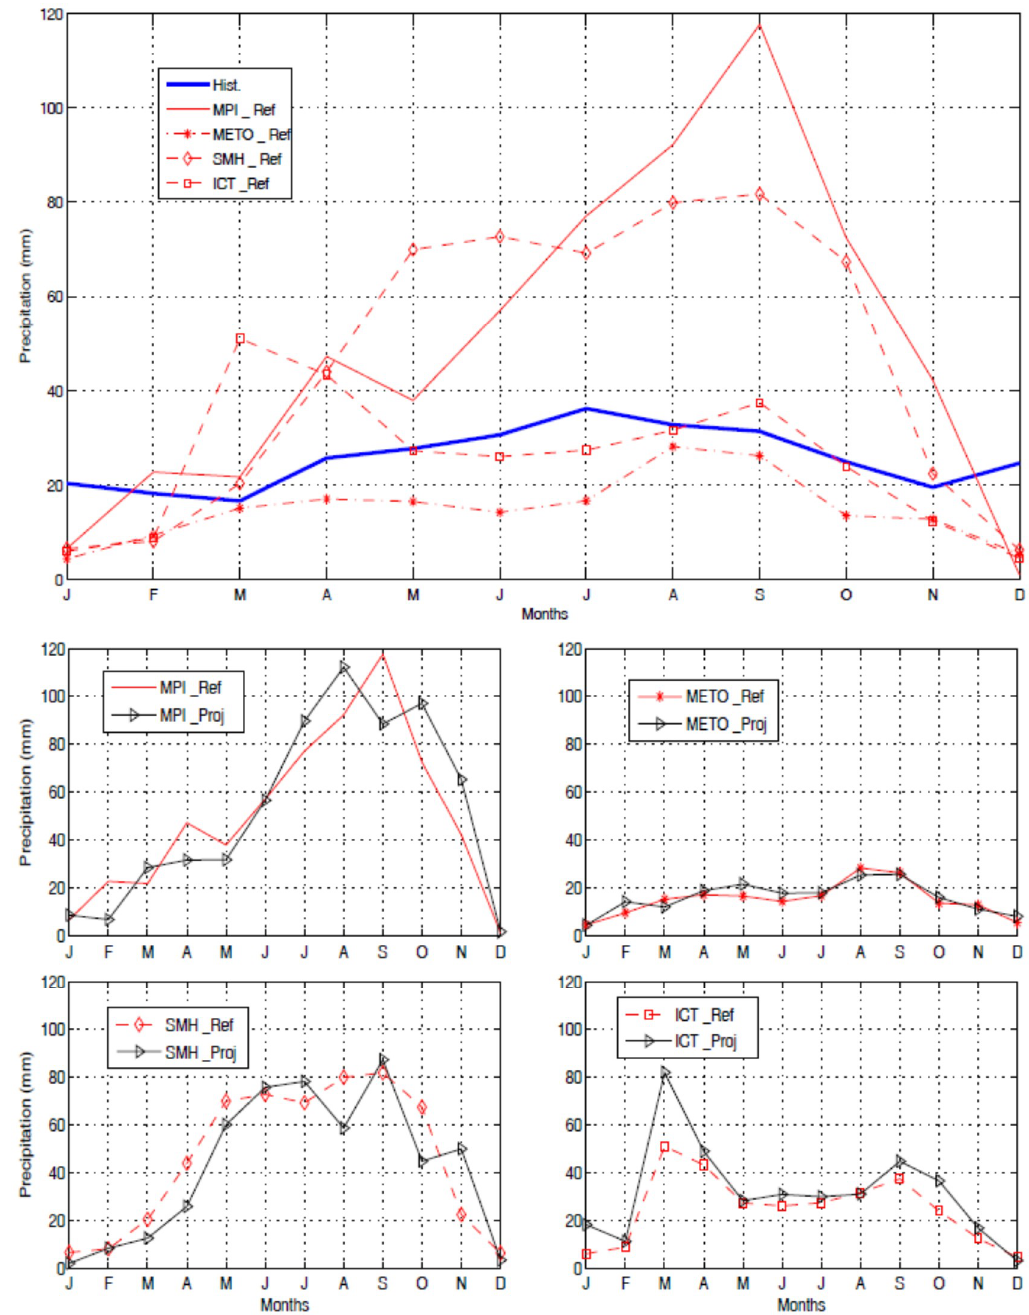
Figure 11. Monthly variation of the 99th percentiles of daily precipitation in the Mono river basin. Top panel: comparison between observation and simulation during the reference period. Bottom panels: comparison between the reference and the projection periods.